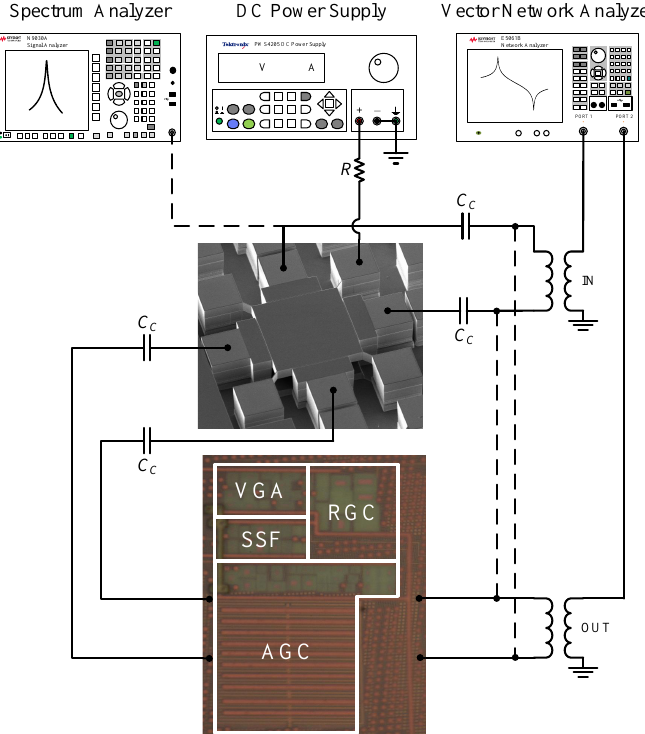
Figure 6. Test setup of the MEMS-based oscillator in open-loop (solid lines) and closed-loop (dashed lines) with micrographs of the TIA and